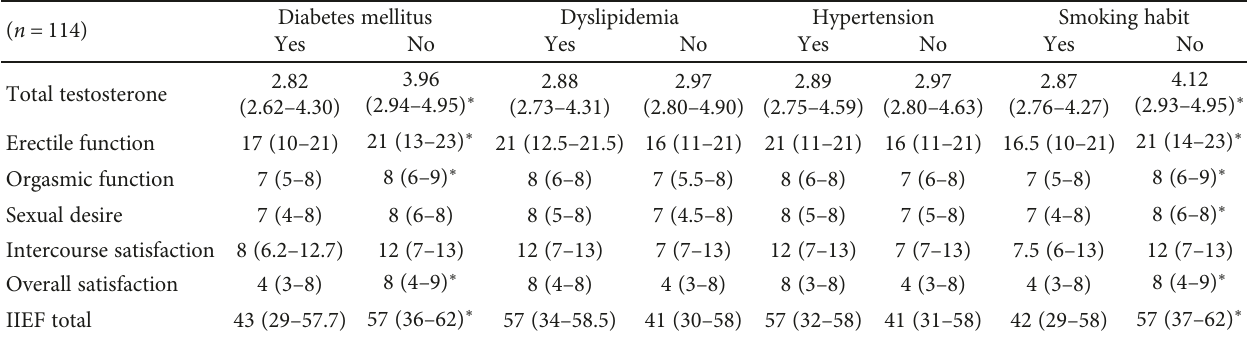
Table 3: Comparison of hormonal and sexual function between subjects a ff ected and not a ff ected by type 2 diabetes mellitus, dyslipidemia, and hypertension and with or without smoking habit in the total sample. Diabetes mellitus ( n = 114 )